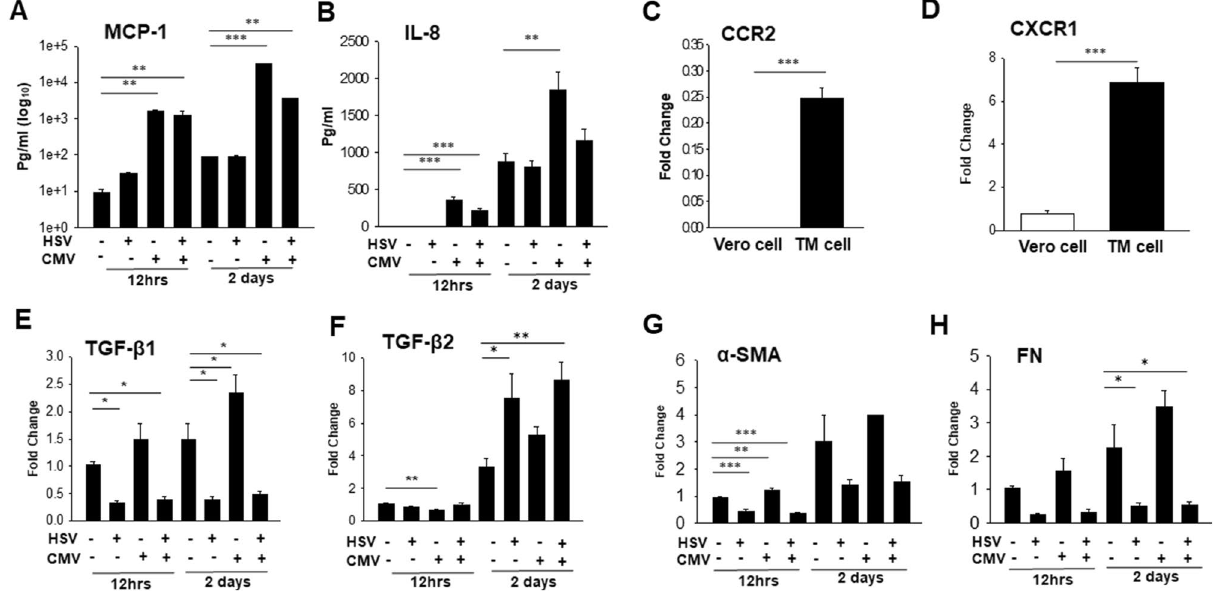
Figure 7. Effects of HSV-1, CMV and their co-infection on the expression of MCP-1 and IL-8 in human trabecular meshwork (TM) cells. Primary TM cells from obtained ScienCell Research Labs were infected at a multiplicity of infection of 1 and observed at 12 h and 2 days post-infection (PI). Supernatants were collected and the levels of MCP-1 ( A ) and IL-8 ( B ) were determined by ELISA assay. Expression of CCR2 ( C ) and CXCR1 ( D ), which are the receptors of MCP-1 and IL-8, respectively, are compared in the Vero cells and human TM cells using real-time qPCR analyses. The mRNA expression levels of transforming growth factor (TGF)-β1 ( E ), TGF-β2 ( F ), α-SMA ( G ), and FN (fibronectin) ( H ) are shown. HSV-1 and CMV infection induced significantly increased expression of MCP-1 and IL-8 in TM cells, showing significant and robust increase of MCP-1 and IL-8 upon CMV infection at 12 h and 2 days PI. Also, the expressions of CCR2 and CXCR1, which are the receptors of MCP-1 and IL-8, respectively, were significantly increased in TM cells, relative to Vero cells, the cell line isolated from kidney epithelial cell. (*** P < 0.001 vs. transcripts from the Vero cells using independent t test; * P < 0.05 and ** P < 0.01 vs. transcripts from the mock infection within 12 h and 2 days PI using one way ANOVA with Dunnett’s multiple comparison, N = 3).